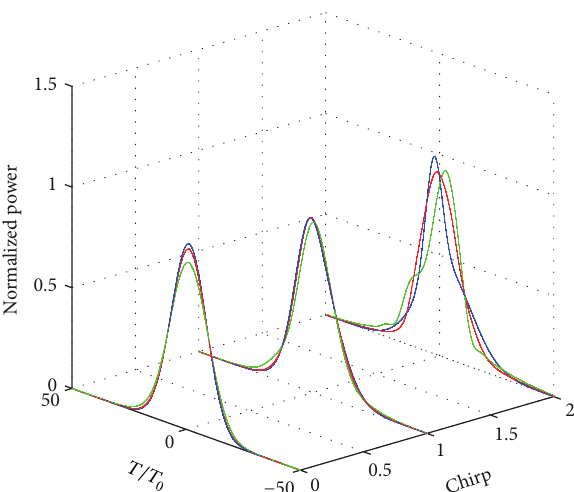
Figure 3: The resulted pulses with Δ𝑡 𝑤 = 30 ps 2 and 𝛽 2 = 0 ps 2 / km for different values of chirp and 𝑘